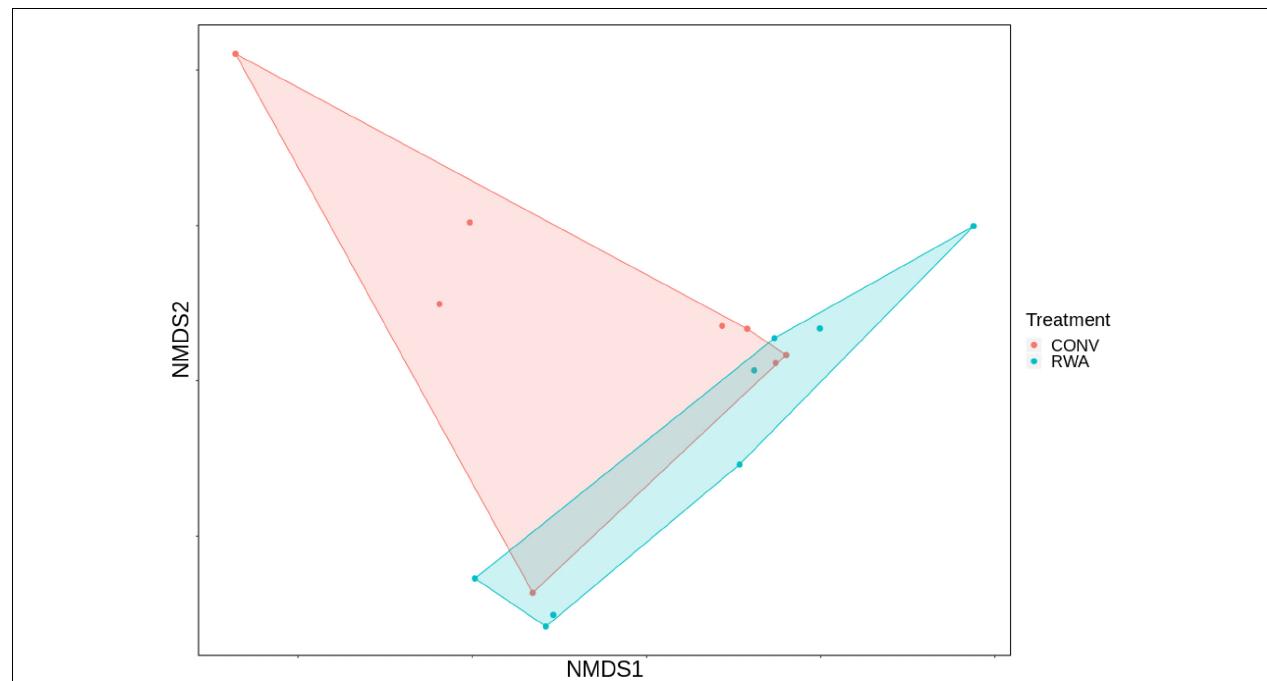
FIGURE 4 | Ordination comparing microbiome composition at the order taxonomic level, using non-metric multidimensional scaling (NMDS), between labeling types on ground beef products; conventional (CONV) vs raised without antibiotics